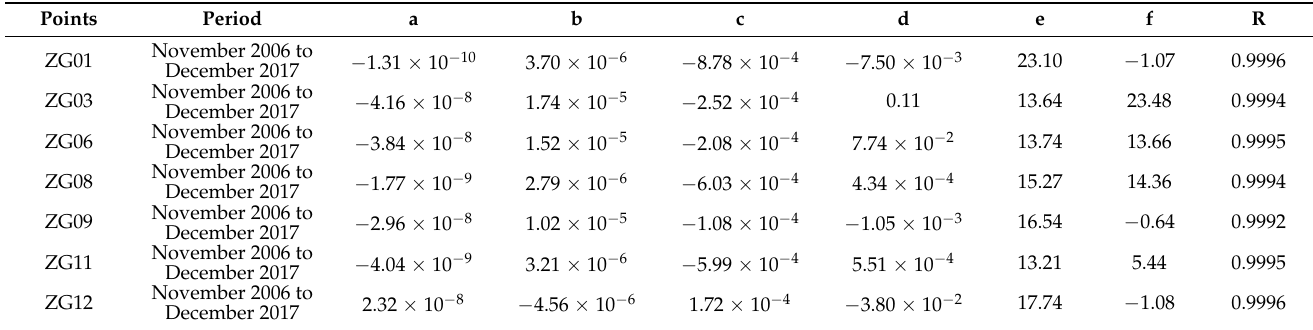
Table 2. The coefficients of the trend displacement polynomial function (Equation (14)).